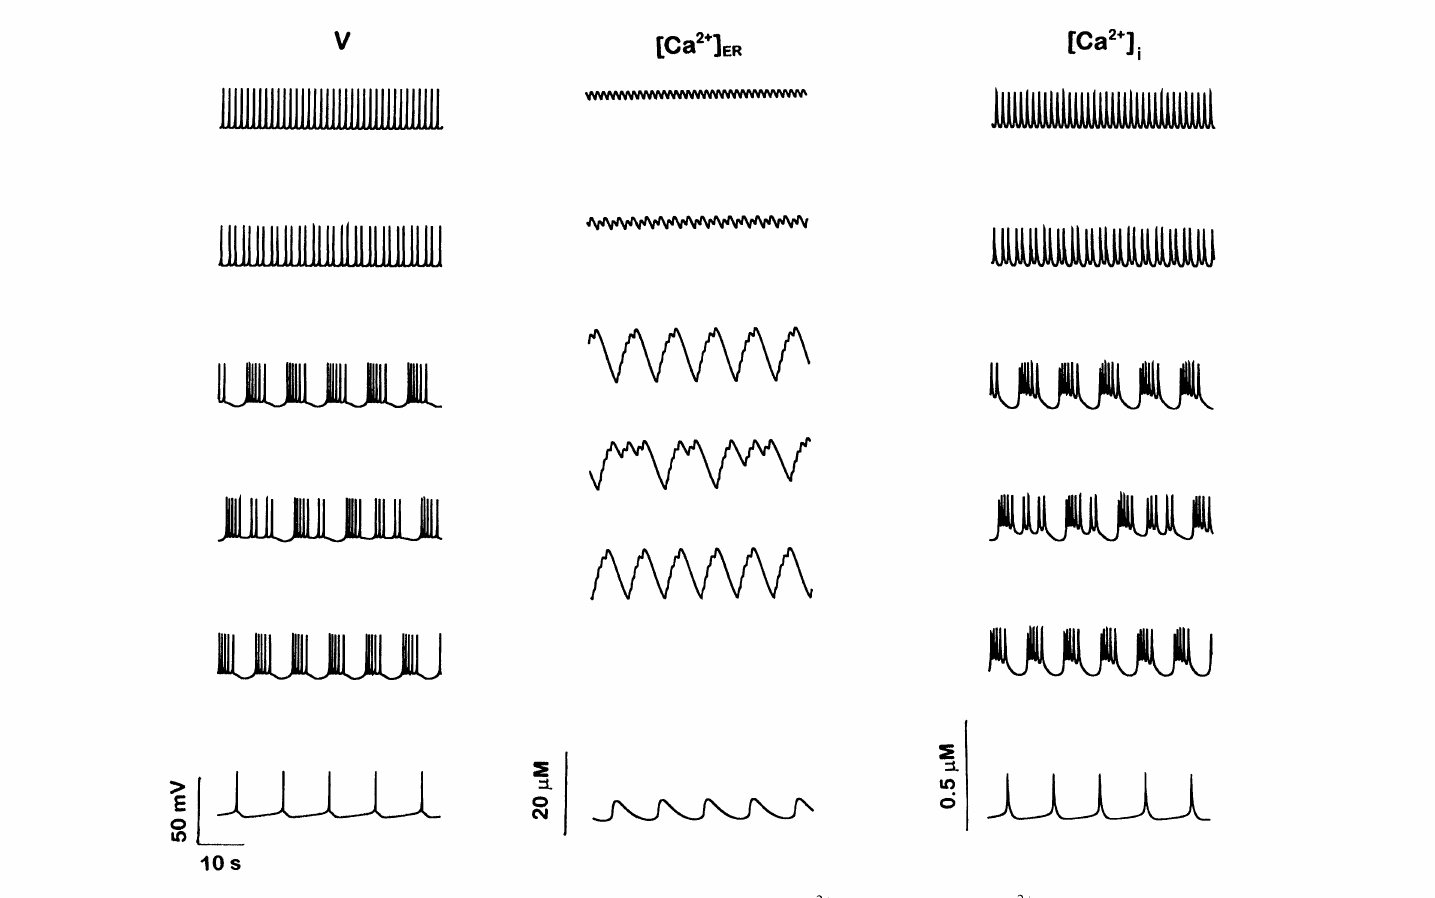
FIGURE 6 Time series generated by the mollusc neuron, where V (left), [Ca2+ ]v, (middle) and [Ca-* ]i (right) are shown in an increasing function of l,pp. From the top to the bottom lu, used for the computations are 5.0, 3.0, 2.0, 1.0, 0.0,- 18.0 btA/cm 2. Note chaos in the fourth trace and doublets in the second